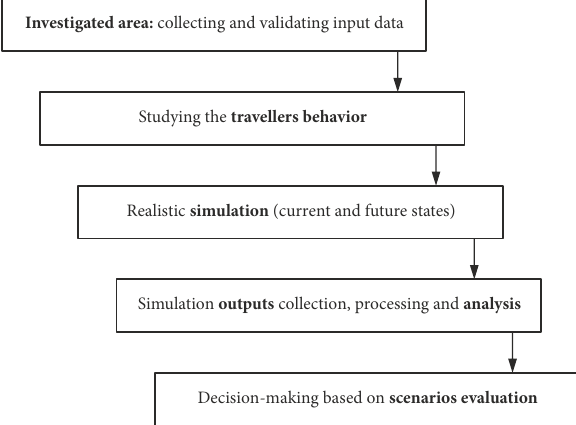
Figure 5. Model-driven decision-making approach for traffic impact assessment